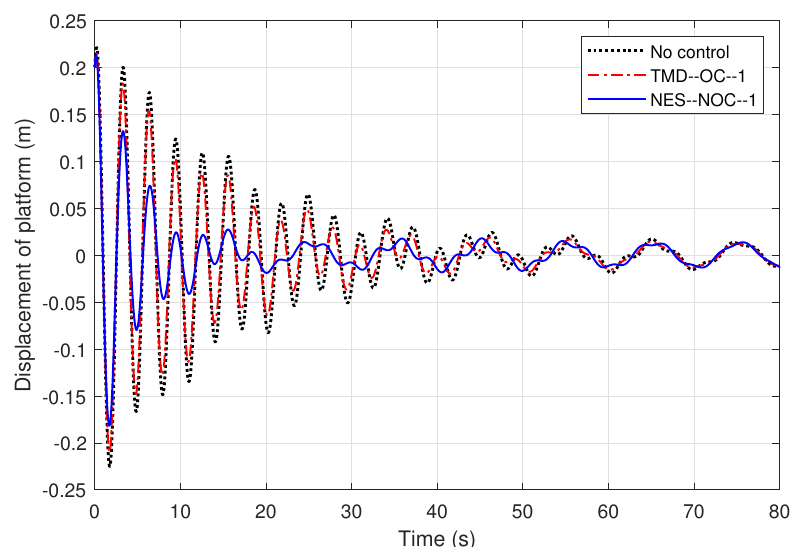
Figure 13. Displacements of the structure without control, with TMD–OC–1 and NES–NOC–1.